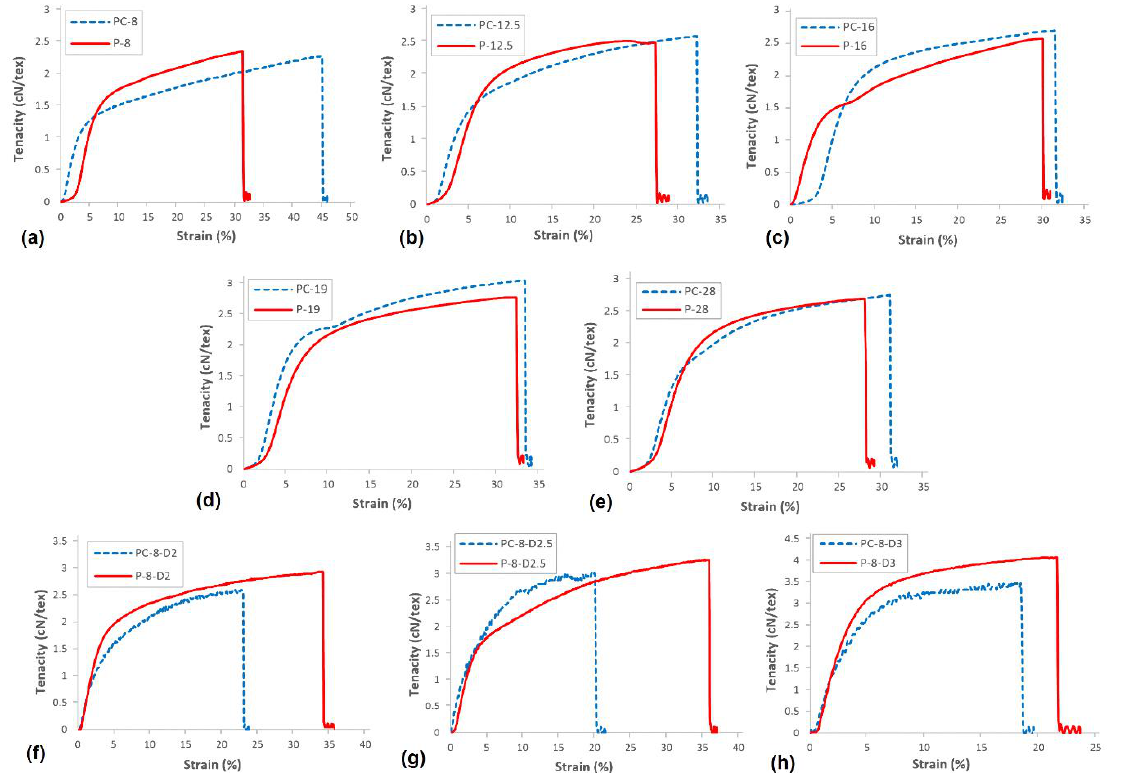
Figure 10. The tenacity–strain curves of PAN and PAN / CNT fibers spun at di ff erent shear rates and jet stretch ratios. ( a ) At shear rate of 8000 s − 1 , ( b ) At shear rate of 12,500 s − 1 , ( c ) At shear rate of 16,000 s − 1 , ( d ) At shear rate of 19,000 s − 1 , ( e ) At shear rate of 28,000 s − 1 , ( f ) At jet stretch ratio of 2, ( g ) At jet stretch ratio of 2.5, ( h ) At jet stretch ratio of